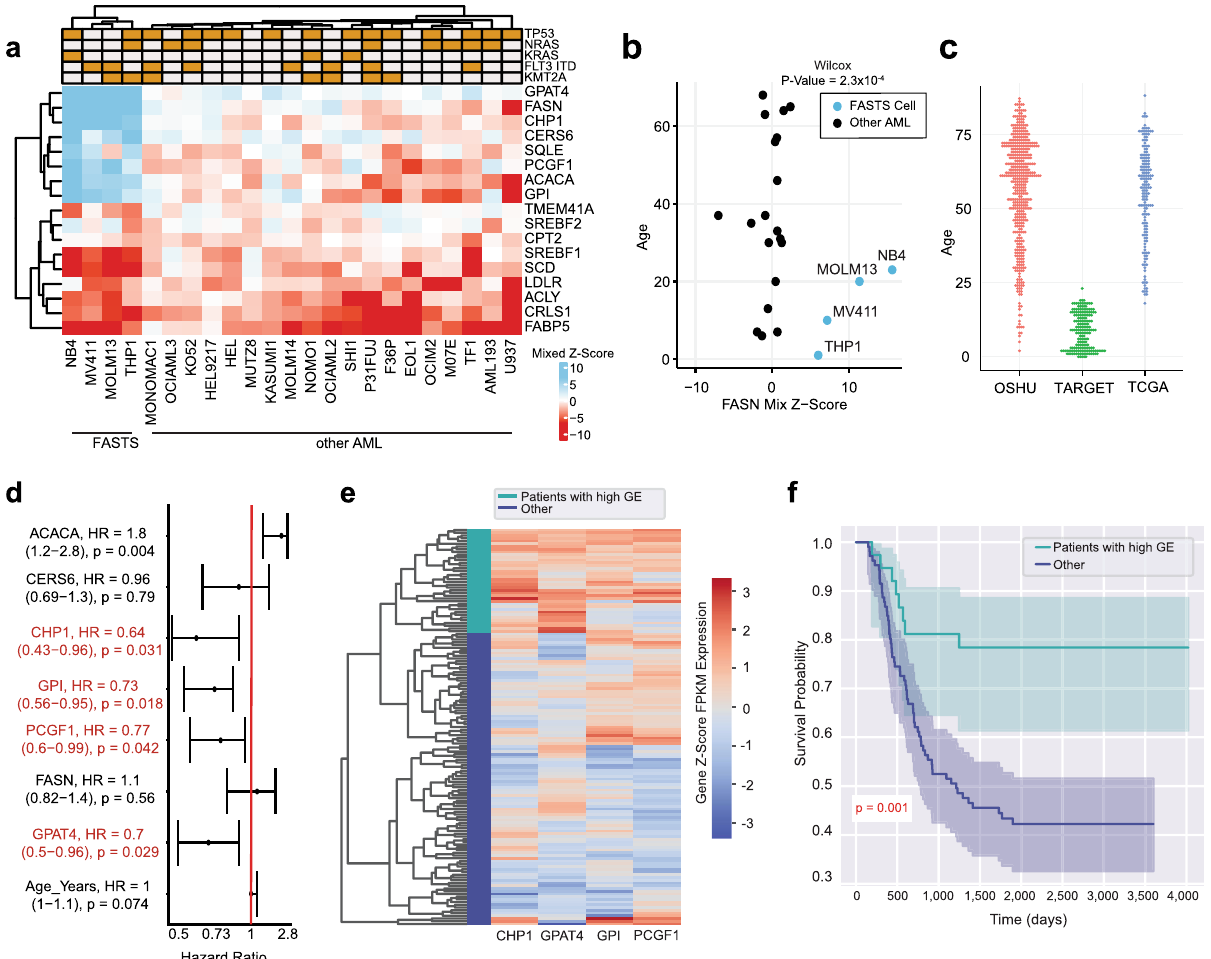
Fig. 6 Prognostic signature of FAS module. a Heatmap of mixed Z -scores for genes implicated in the genetic interaction network. Top, common AML lesions. b Mixed Z -score of FASN in AML cell lines vs. age of patient from which cell lines were derived. Blue, FASTS cells. c Age distribution of AML patients in three public tumor genomics cohorts. Red denotes OSHU, green denotes TARGET, and blue represents TCGA. d Hazard ratios (95% CI; univariate Cox proportional-hazards test) for expression of genes in ( a ), using genomics and survival data from TARGET. The dot represents the HR value indicated on the right. The 95% CI range for each point is indicated on the left. Genes indicated in red represent genes with signi fi cant HR less than 1 and are used for analysis in ( e ). e Hierarchical clustering of gene expression in TARGET, using the four genes with negative HR. Green, high expression cluster. Blue, others. f Kaplan – Meier survival analysis of AML patients in TARGET, comparing patients in high expression cluster vs. others. Shaded regions represent 95% CI of the curve. The number of independent patients analyzed in ( d – f ) =